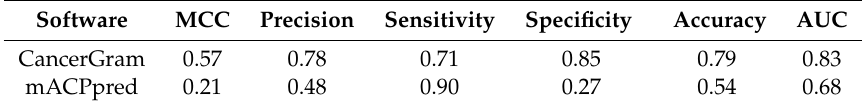
Table 5. Comparison of CancerGram and mACPpred [49] performance on the validation data set, from which sequences used for mACPpred training were removed. The final data set contained 128 ACPs and 170 AMPs. CancerGram predictions were